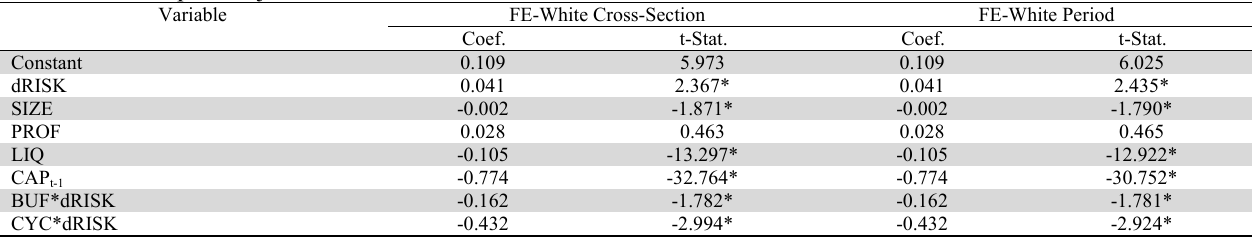
The Results of Capital Adjustments Based on FE with Robust Standard Error Variable FE-White Cross-Section FE-White Period Coef. t-Stat.